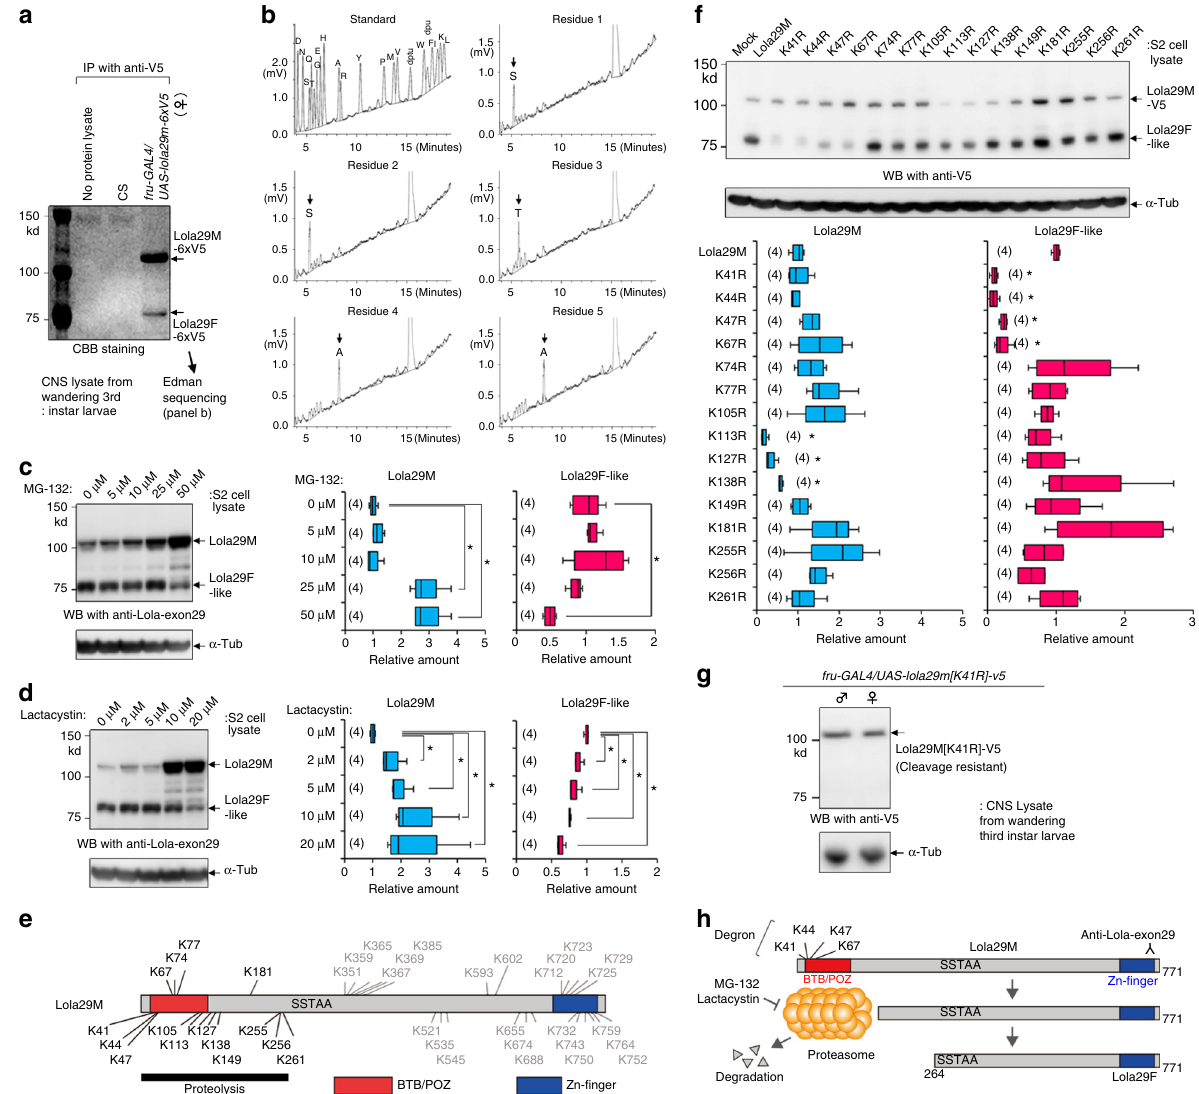
Fig. 2 Proteasome involvement in the production of Lola29F. a A coomasie brilliant blue (CBB) stained PVDF membrane showing results from the biochemical puri fi cation of Lola29M and Lola29F. lola29m-6xv5 was overexpressed via fru-GAL4 in female larvae, from which the CNSs were dissected to extract proteins for immunoprecipitation. The band representing Lola29F (arrow) was transferred to a PVDF membrane and subjected to Edman sequencing. b HPLC pro fi les of Edman sequencing of Lola29F. The 20 known amino acids served as standard (top-left panel). The fi rst fi ve amino acids of the N-terminal region of Lola29F were determined to be SSTAA, which corresponds to the a.a.264-a.a.268 in Lola29M. c , d Western blotting of S2 cell extracts probed with anti-Lola-exon 29 (upper panel). Administration of proteasome inhibitors MG-132 ( c ) or lactacystin ( d ) reduced the amount of Lola29F-like. α -Tubulin was used as a loading control (lower panel). Effects of inhibitors on the amounts of Lola29M and Lola29F-like are shown on the right-hand side. * P < 0.05 by the Kruskal – Wallis analysis of variance followed by Steel ’ s nonparametric multiple comparisons. e Distribution of lysine residues throughout the Lola29M protein. f Western blot analysis of transfected S2 lysates for Lola29M and Lola29F-like revealed a marked decline in the amount of Lola29F-like with K41R, K44R, K47R and K67R substitutions. * P < 0.05 by the Kruskal – Wallis analysis of variance followed by Steel ’ s nonparametric multiple comparisons. g Shown is a western blot of extracts obtained from the larval CNS probed with anti-V5 that recognizes the C- terminus of a Lola29M variant. Replacement of the lysine residue at a.a. 41 with arginine (K41R) in the Lola29M-encoding sequence blocked the production of Lola29F in females (right lane). h The hypothesis that Lola29F is derived from Lola29M by truncation of the N-terminus with a BTB domain. Edman degradation analysis identi fi ed the N-terminus of Lola29F-like as SSTAA, which corresponds to a.a. 264 – 268 of Lola29M. The four distal-most lysine residues (K41, K44, K47, and K67) are postulated to form a degron, a set of degradation signals. The box plot shows median and 10th, 25th, 75th, and 90th percentiles ( c , d , f ). Source data are provided as a Source Data fi